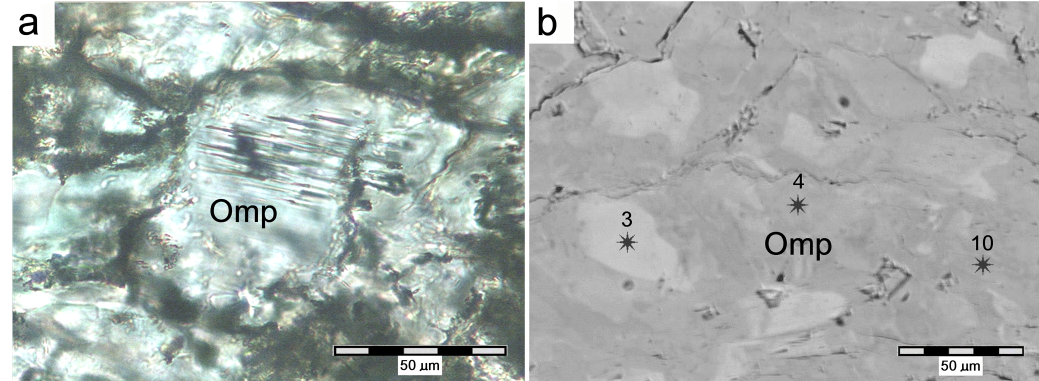
Figure 8. Photomicrographs of omphacitite: (a) pyroxene matrix, in which small omphacite crystals (Omp) that are green in colour and typi- cally zoned show tiny, darker and similarly oriented inclusions in their core (4360, PPL). (b) Complex zoning of pyroxenes: a heterogeneous, darker matrix (richer in Na and Al) including small, lighter domains that are richer in Ca and Mg (4360, SEM image, BSE) the numbered stars indicate the spots in which EDS analyses were collected (see Table